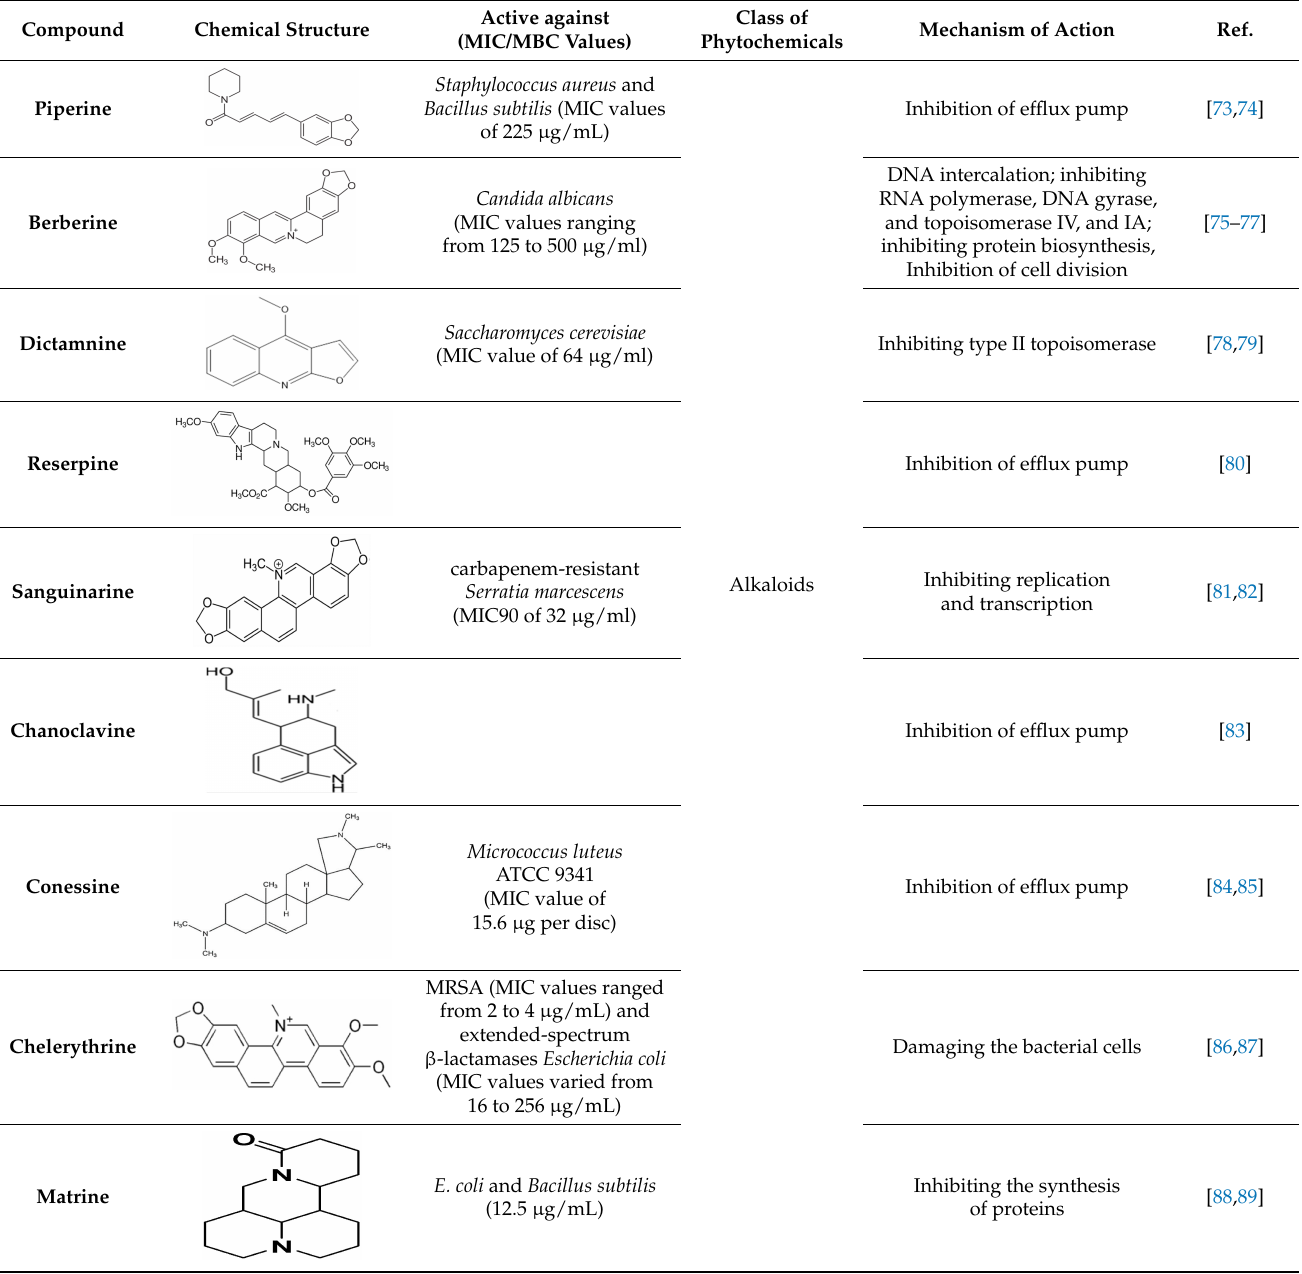
Table 1. The most prevalent natural antibacterial compounds with the related mechanism of